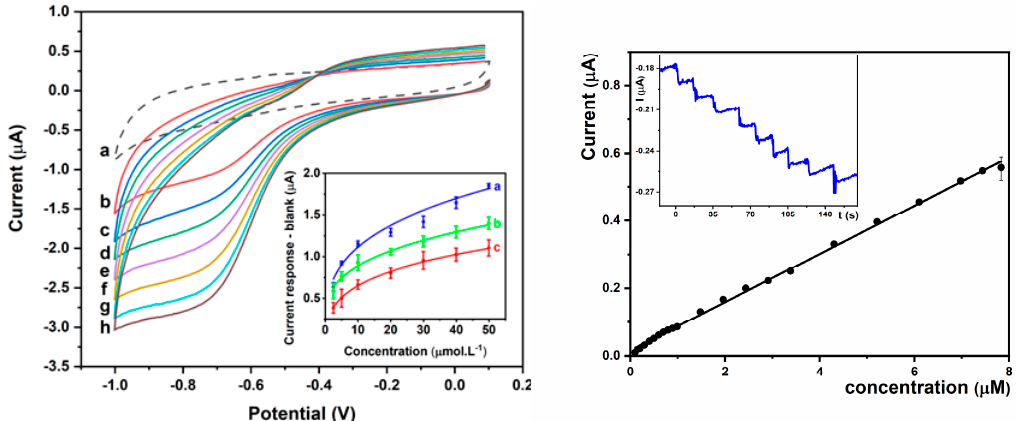
Figure 3. Left image : cyclic voltammograms CVs of the prepared SOx / MXene-Chi / GCE biosensor in 0.1 M PB pH 7.4 purged by N 2 containing 0 ( a ), 2.5 ( b ), 5 ( c ), 10 ( d ), 20 ( e ), 30 ( f ), 40 ( g ), 50 ( h ) µ M sarcosine at a scan rate of 100 mV s − 1 in a potential window from − 1.0 V to + 0.1 V. Inset: Calibration plots obtained when using no glutaraldehyde ( a , blue line), 1% glutaraldehyde ( b , green line) and 5% glutaraldehyde ( c , red line) during fabrication of the biosensor. Right image : Plot of current responses after subtraction of blank (current response obtained in the absence of sarcosine) of the SOx / MXene-Chi / GCE biosensor measured on a rotating disc glassy carbon electrode at − 0.7 V and 900 rpm versus sarcosine concentration. Inset: a current versus time response of the SOx / MXene-Chi / GCE biosensor at − 0.7 V to successive addition of stock sarcosine solution in stirred nitrogen-purged 0.1 M phosphate bu ff er, pH 7.4.